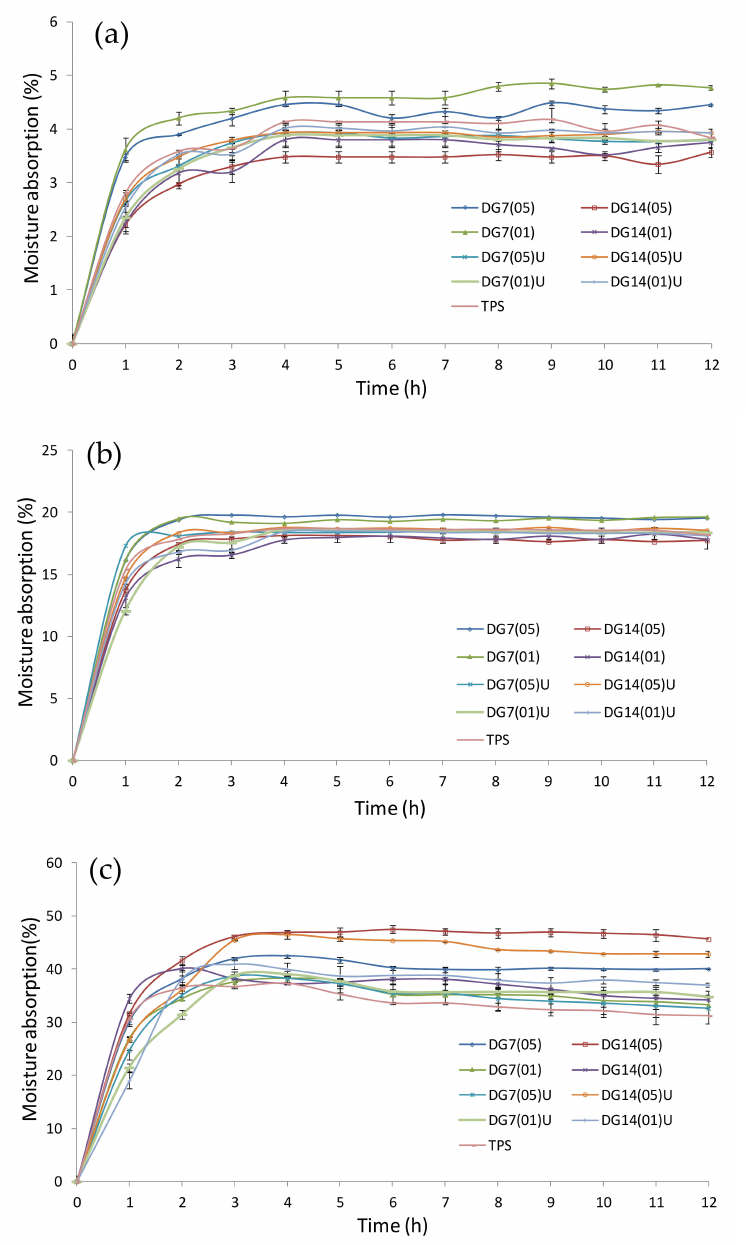
Figure 8. Course of changes in absorption of moisture from air by biocomposites. ( a ) Relative humidity, RH—50%; ( b ) relative humidity, RH—75%; ( c ) relative humidity,